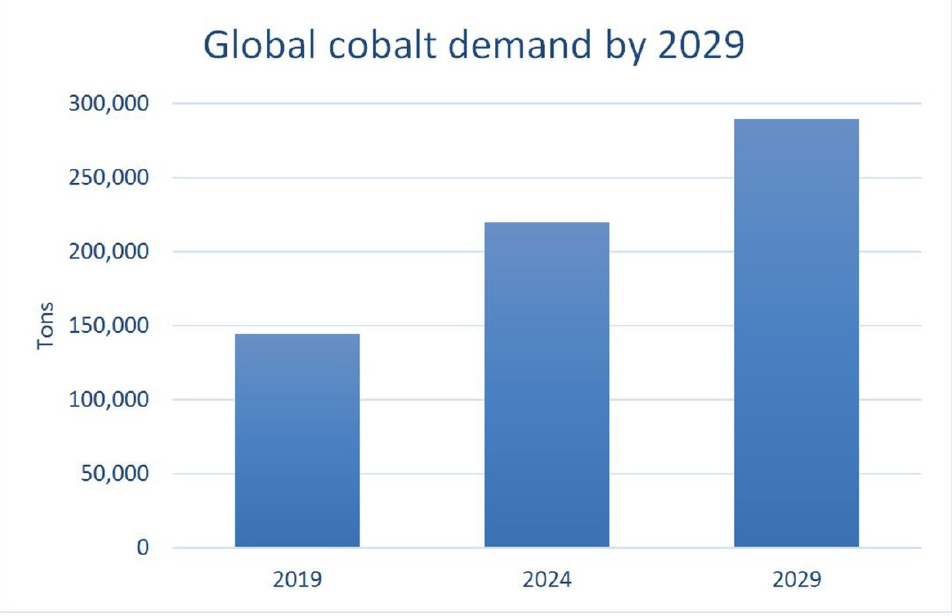
Figure 3. Forecast of the global cobalt demand by 2029 [7,8].